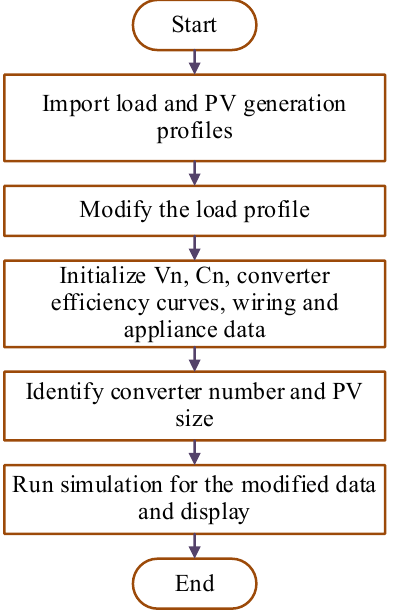
Figure 4. Flow diagram of simulation process.